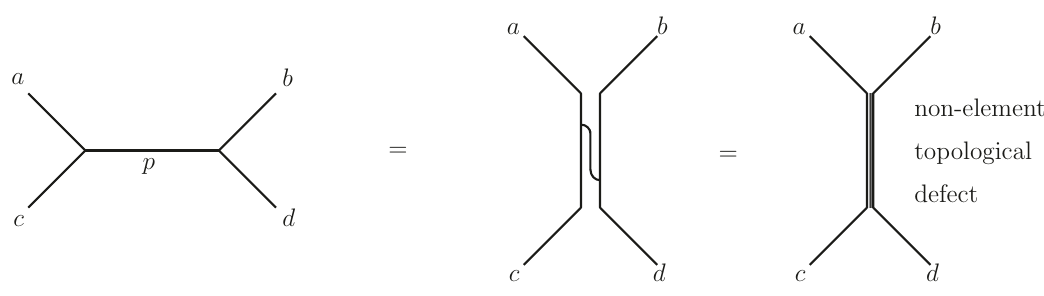
Figure 2 . The topological nature of defects implies that an“s-channel” configuration with an elementary defect should be equivalent to a “t-channel” configuration with a composite, but still topological defect.